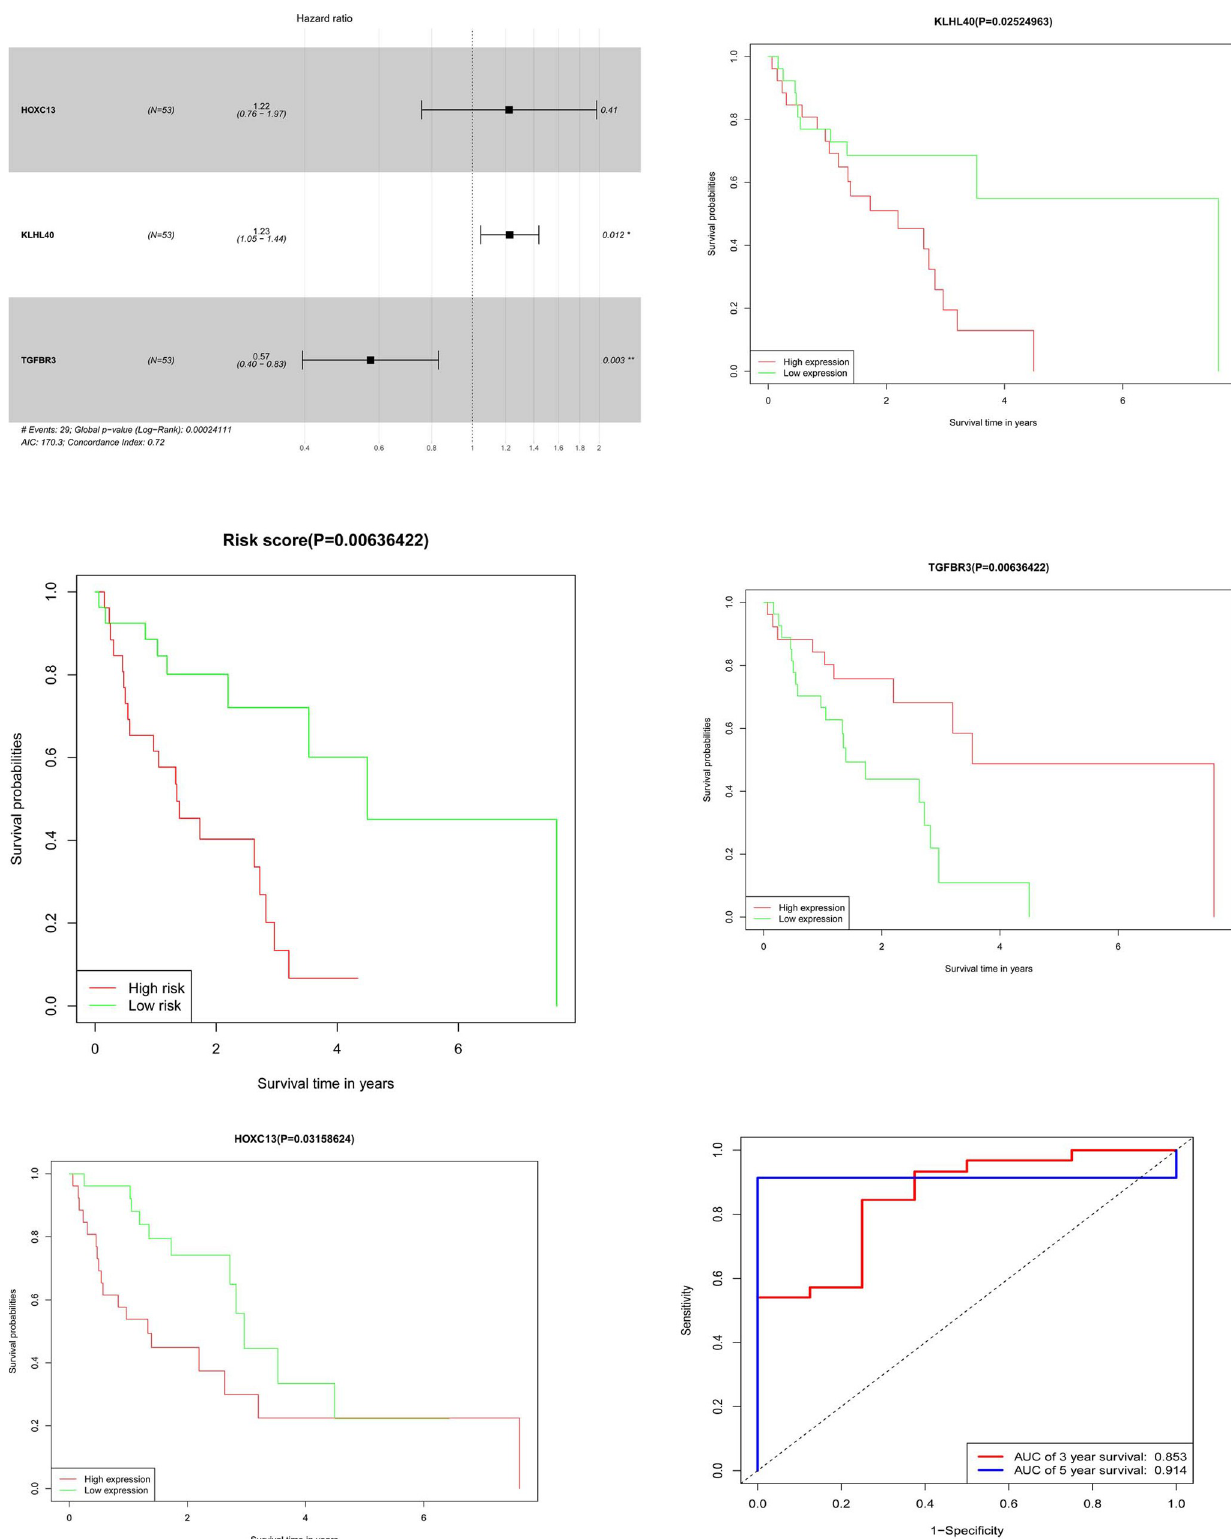
Fig 5. (A) Multivariate Cox regression analysis in patients with OFSCC, (B) Risk score analysis of 3 key mRNA signatures, (C, D, E) Kaplan-Meier survival curves for key mRNAs, (F) ROC curve of risk score for predicting 3-y and 5-y survival.